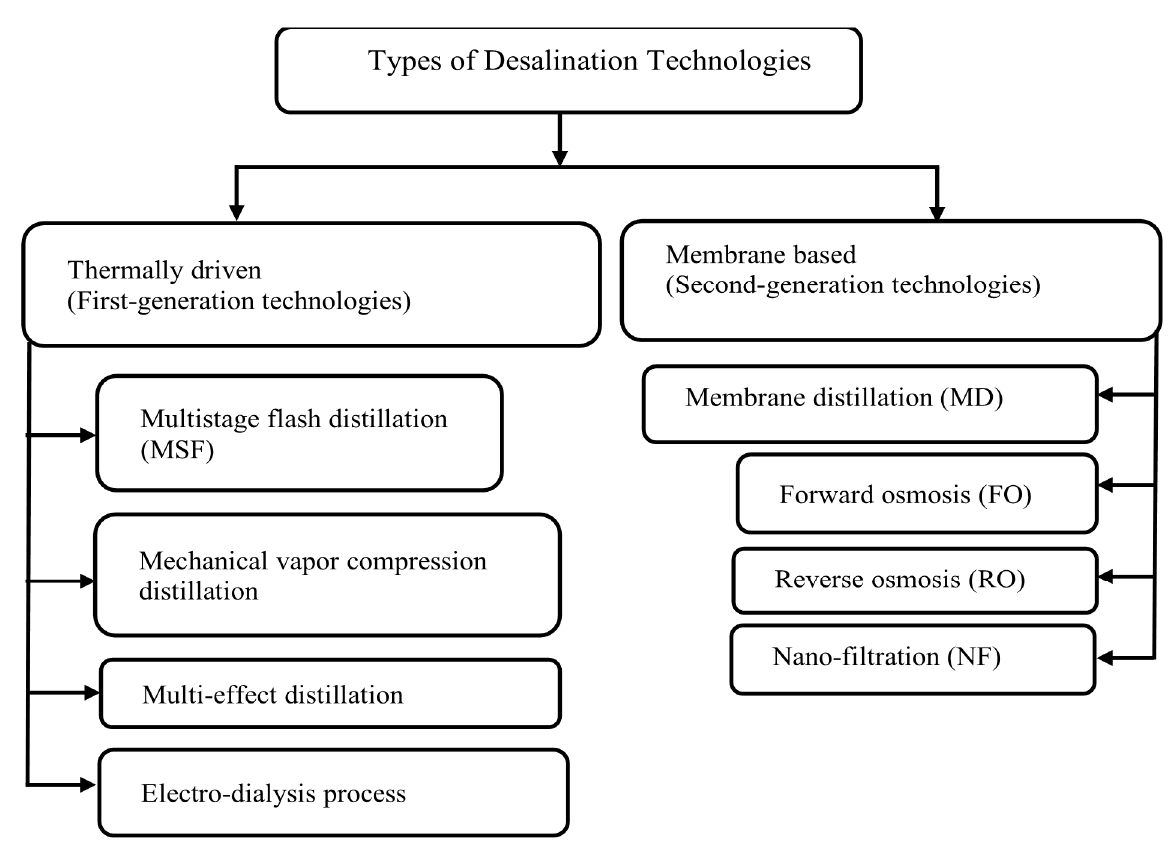
Figure 1. Types of desalination technologies.